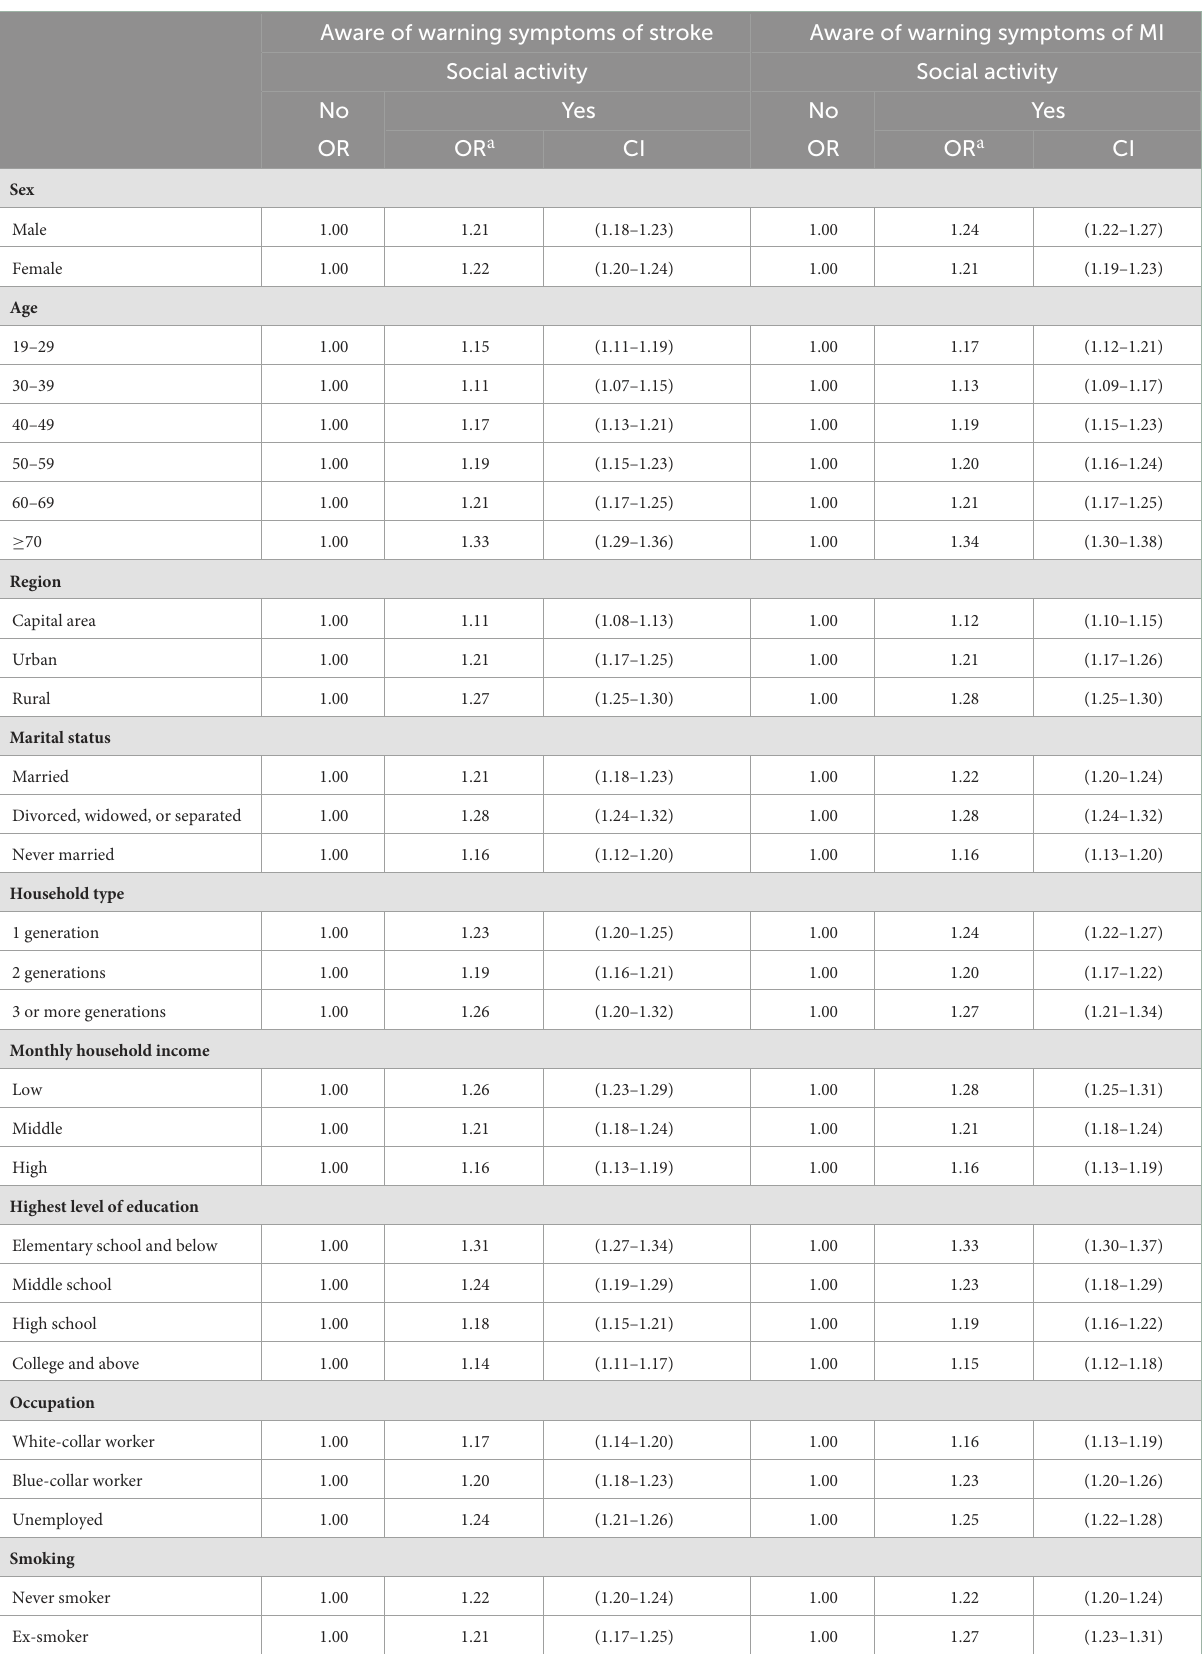
TABLE3 Subgroupanalysisof the association between social activities andawareness ofwarningsymptoms ofstroke andMIstratifiedby